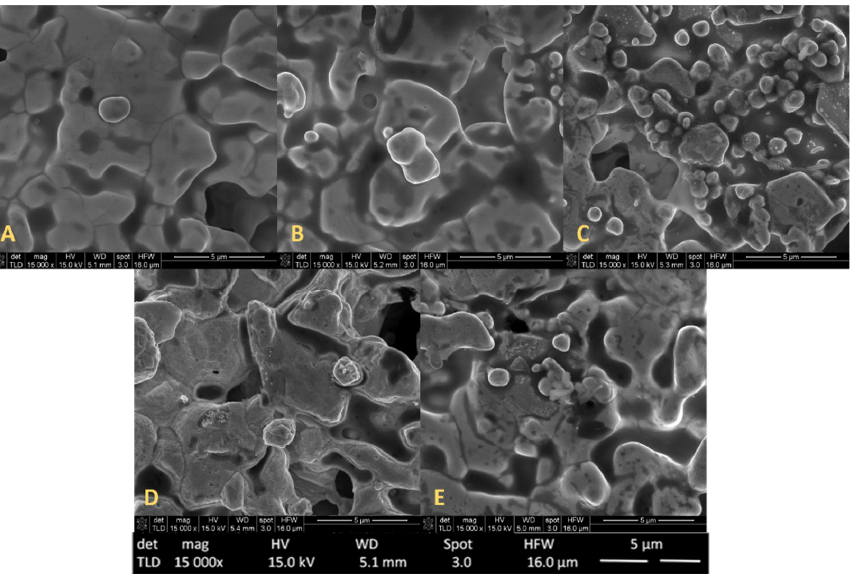
Figure 11. SEM images of gold working electrode after each cleaning method: ( A ) untreated; ( B ) acetone; ( C ) ethyl alcohol; ( D ) H 2 O 2 ; ( E ) electrochemical. tone; ( C ) ethyl alcohol; ( D ) H 2 O 2 ; ( E ) electrochemical.